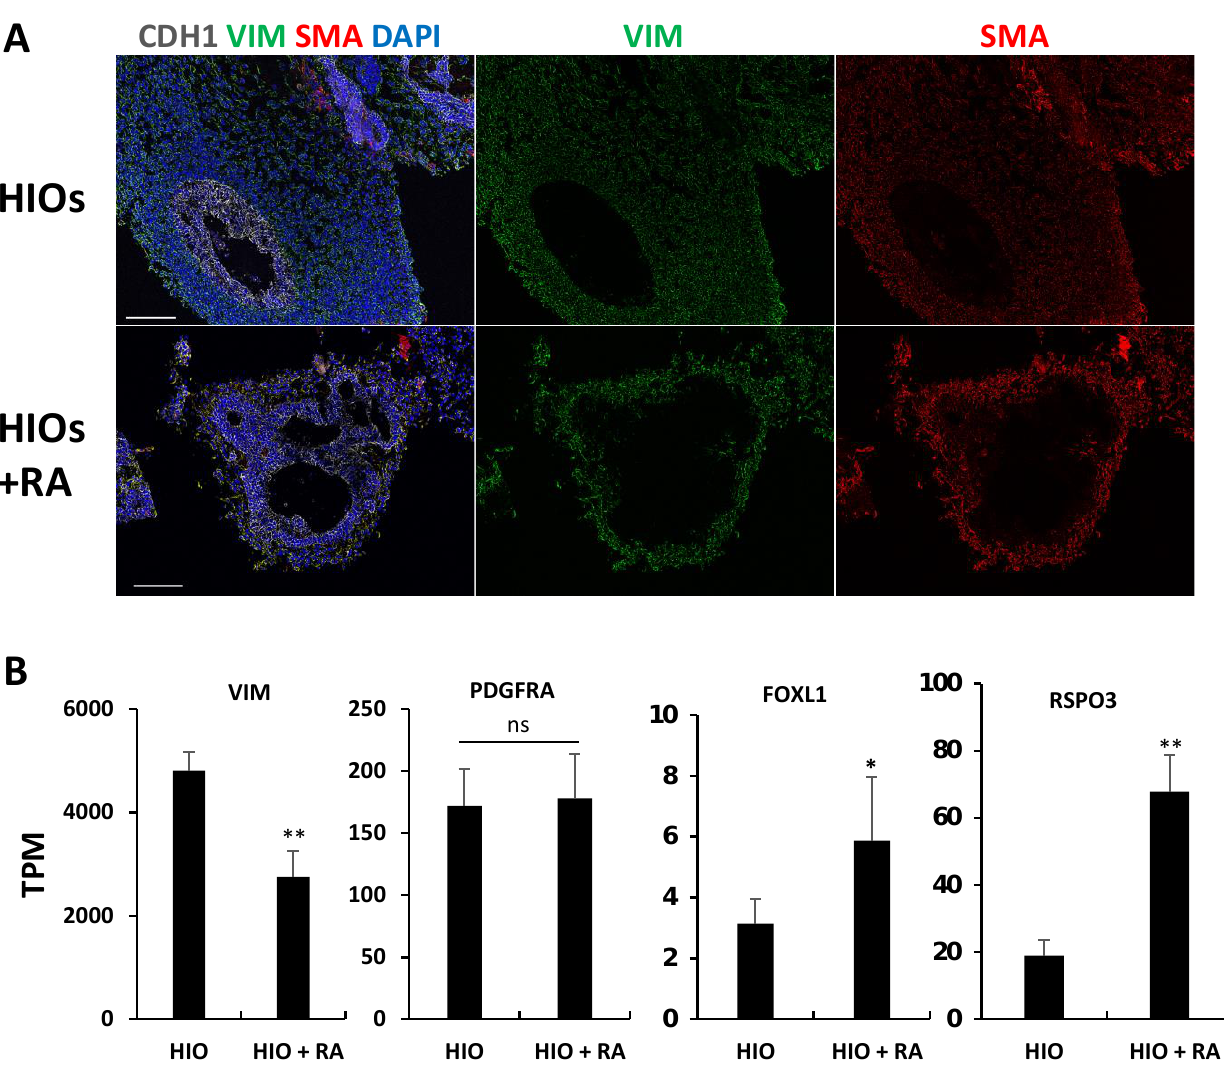
Figure 5. Retinoic acid enriches epithelium-supportive mesenchyme. ( A ) Immunofluorescence staining of 35-day-old organoids from (HIOs and HIOs + RA) for CDH1(white), VIM (green), SMA (red) and counterstained with DAPI. ( B ) Graphs of TPM values of epithelial genes from RNA-seq data of 35-day-old HIOs and HIOs + RA. Values are displayed as the mean ± SD. n = 4 per treatment group. * denotes a p value < 0.05. ** denotes a p value < 0.01 based on t